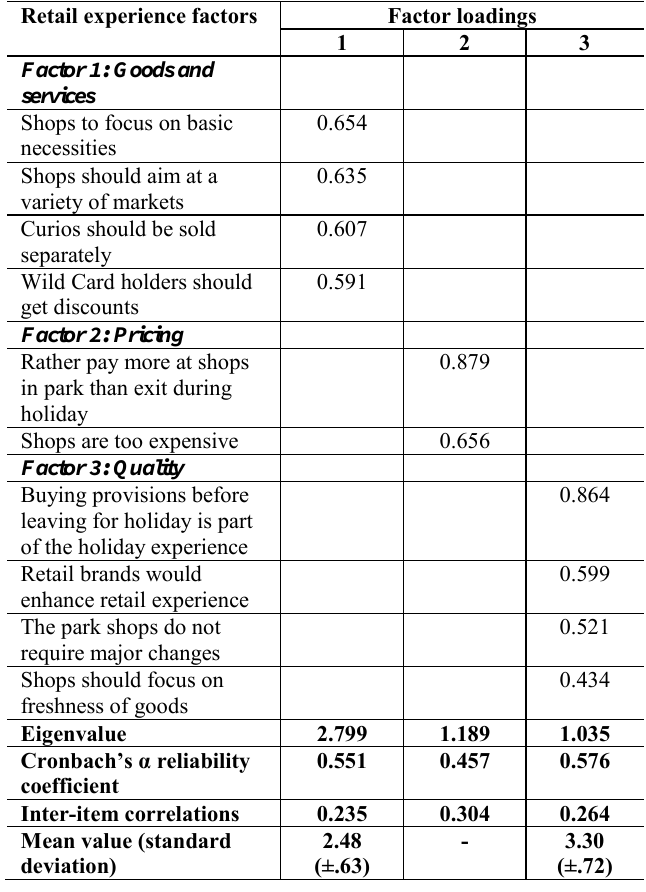
Table 3: Results of the factor analysis for